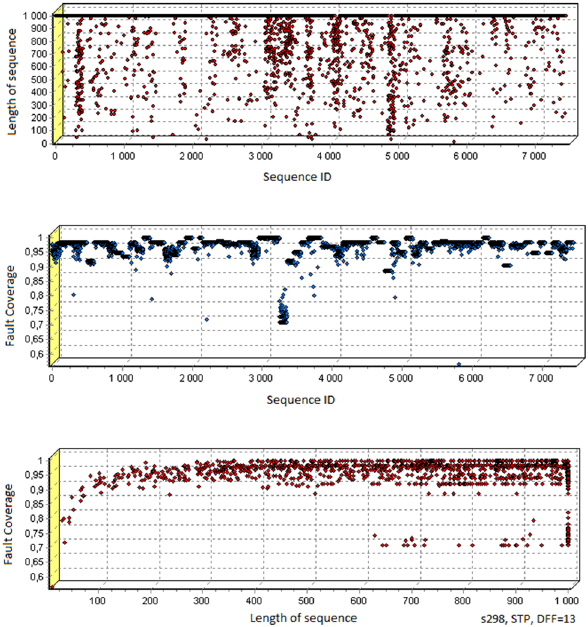
Fig. 34 STP for s298 with use of 13 internal flip-flops